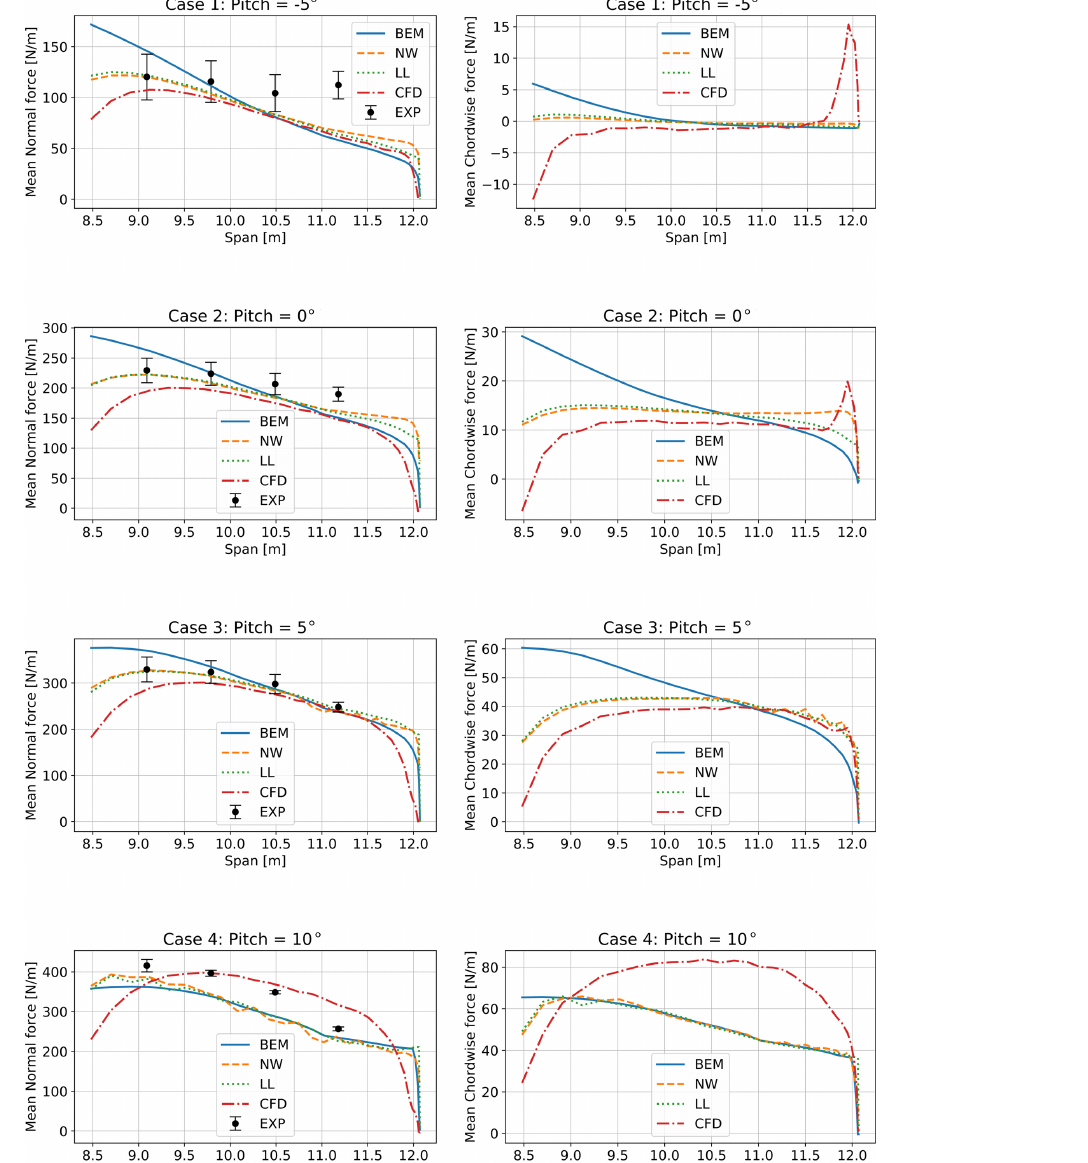
Figure 12. Comparison of normal (left panels) and chordwise (right panels) load distribution obtained from simulations and measurements. Results shown are averaged from four simulations per pitch angle, see Table